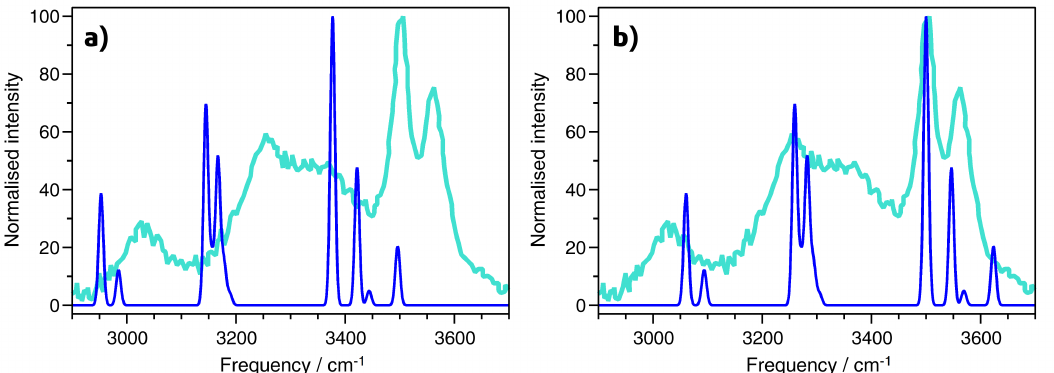
Figure 2. Comparison of DFT-computed Raman spectrum (blue) to experimental data (cyan) [7]. ( a ) Unscaled PBE-TS spectrum. ( b ) PBE-TS spectrum scaled by a factor of 1.037.